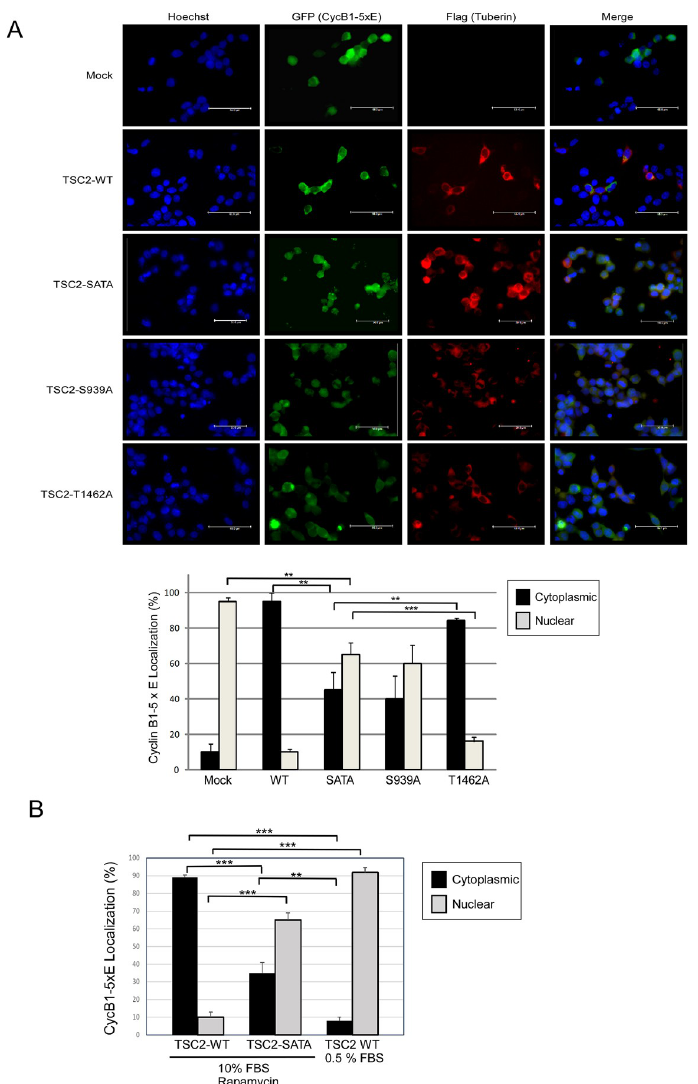
Fig 2. Akt phosphorylation of Tuberin regulates the localization of CycB1 and mitotic onset. HEK293 cells transfected with CycB1-5xE-GFP were co-transfected with either empty vector (Mock), TSC2-WT, TSC2-SATA, TSC2-S939A or TSC2-T1462A. (A: top panel) Representative immunocytochemistry showing Hoechst (Blue; first column), CycB1-GFP (Green; second column), Flag-TSC2 Texas Red (red; third column) and merge (last column). (A: bottom panel) Graph represents the percentage of CycB1-5xE found in the cytoplasm (solid bars) or nucleus (grey bars). Errors represent SD over 3 separate transfections. Unpaired t-test, �� p < 0.01 and ��� p < 0.001. (B) HEK293 cells transfected with CycB1-5xE-GFP were co-transfected with TSC2-WT or TSC2-SATA. 18 hrs following transfection, cells were washed with PBS and incubated for 2 hrs with 0.5% or 10% FBS, followed by the addition of either vehicle control or Rapamycin (100nM) for 4 hrs prior to lysis. Graph shows the percentage of CycB1-5xE localized to the cytoplasm (solid bars) or nucleus (grey bars). Error bars represent SD over 3 separate transfections. Unpaired t-test, �� p < 0.01 and ��� p >